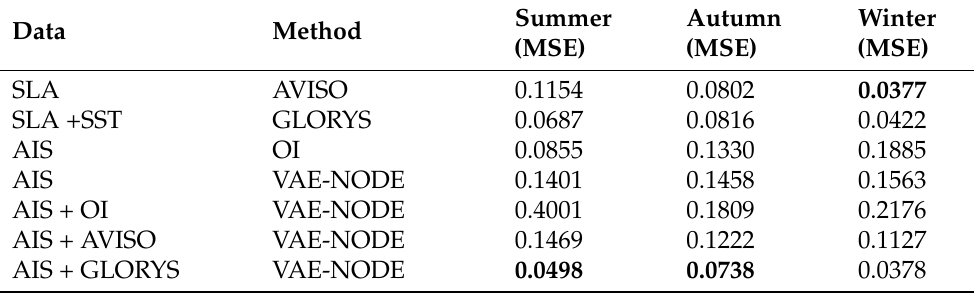
Table 1. Reconstruction performance evaluate from independent in situ